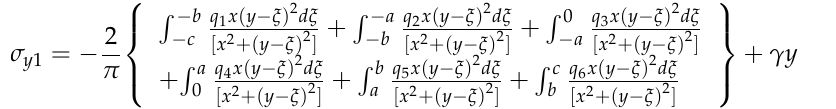
The additional vertical stress generated by the narrow coal pillar is: